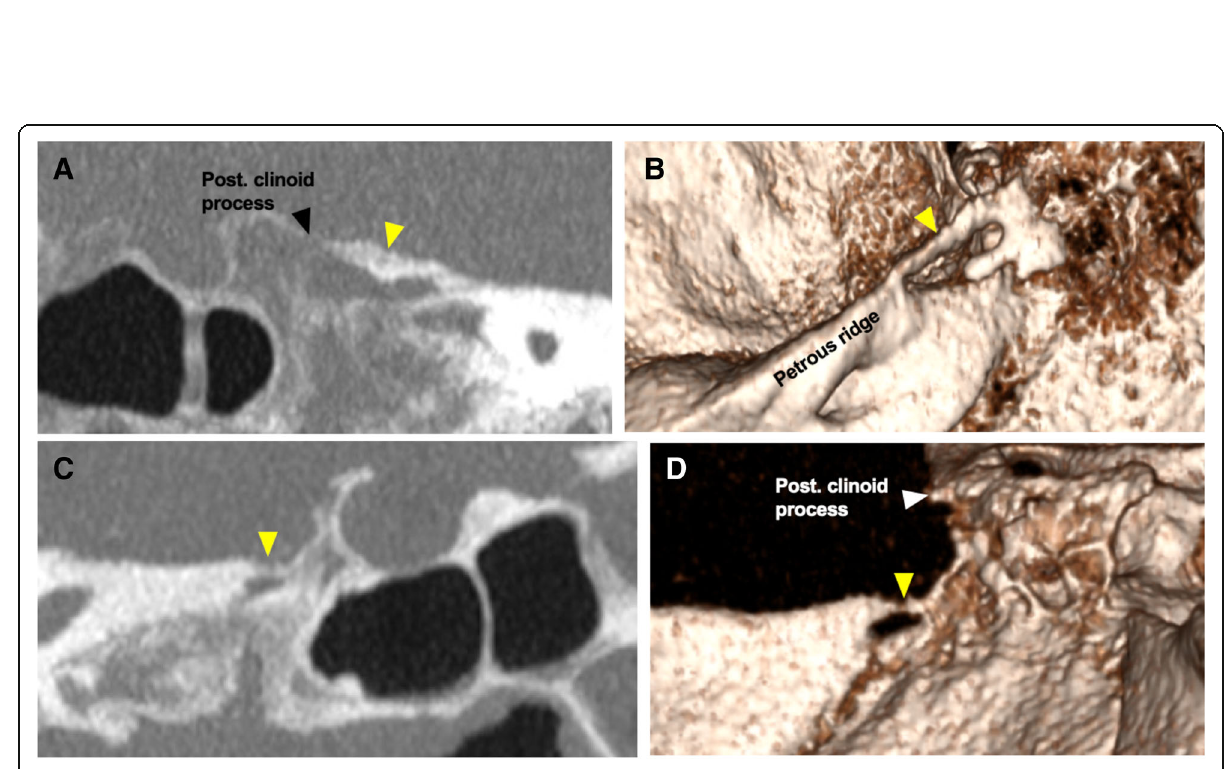
Fig. 1 Mineralised caroticoclinoid and interclinoid ligaments. Axial ( a ), sagittal oblique ( b ), and 3D ( c ) volume reconstruction demonstrating a complete interclinoid ligament on the right (yellow arrowhead). Axial CT ( d ) and 3D ( e ) volume reconstructions demonstrating bilateral complete caroticoclinoid ligaments (yellow arrowheads). f 3D reconstruction demonstrating the right-sided complete caroticoclinoid ligament (yellow arrowhead)